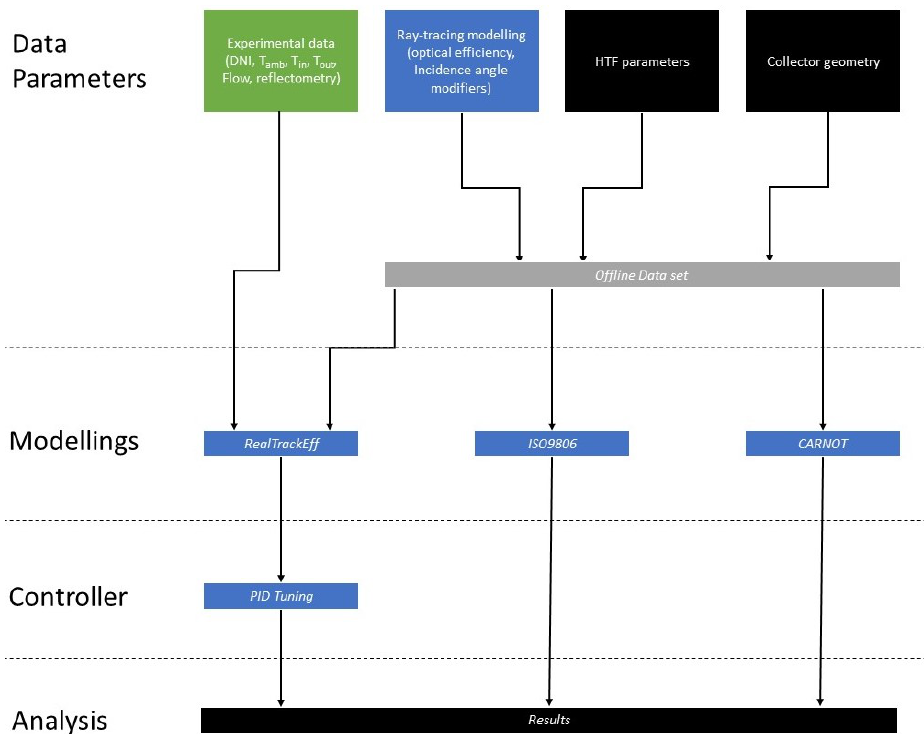
Figure 2. Flow diagram of the comparative modellings.